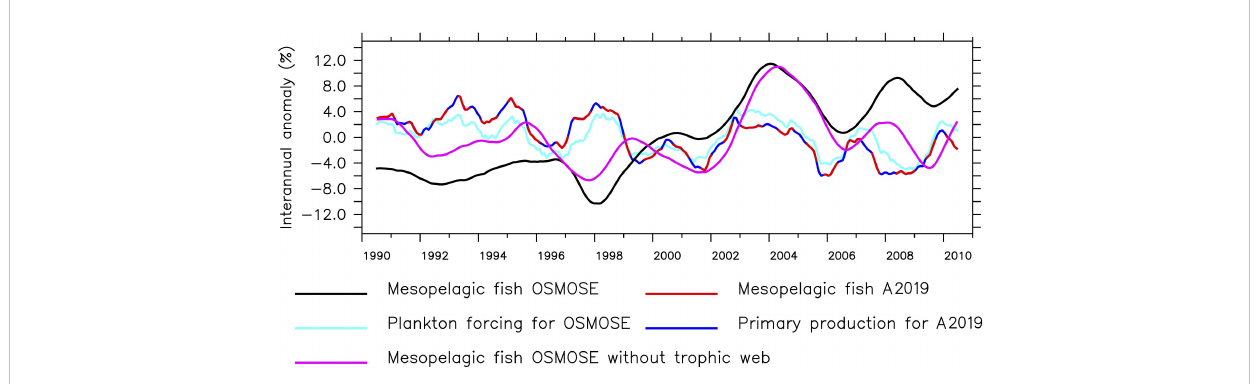
FIGURE 2 Anomaly of the 12-month running mean of total mesopelagic fi sh biomass calculated by OSMOSE and the model by A2019, primary production used as input for the model by A2019, total plankton biomass used to force OSMOSE and OSMOSE mesopelagic fi sh when all other fi sh groups were collapsed (see Section